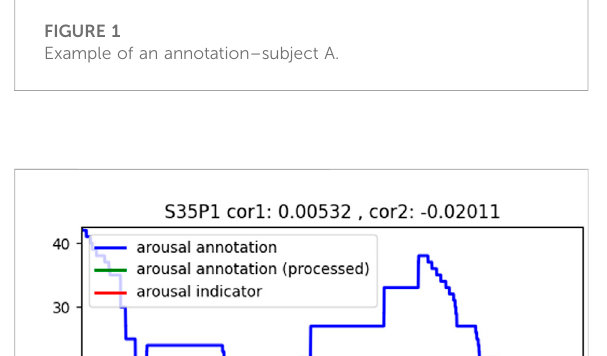
FIGURE 1 Example of an annotation – subject A.